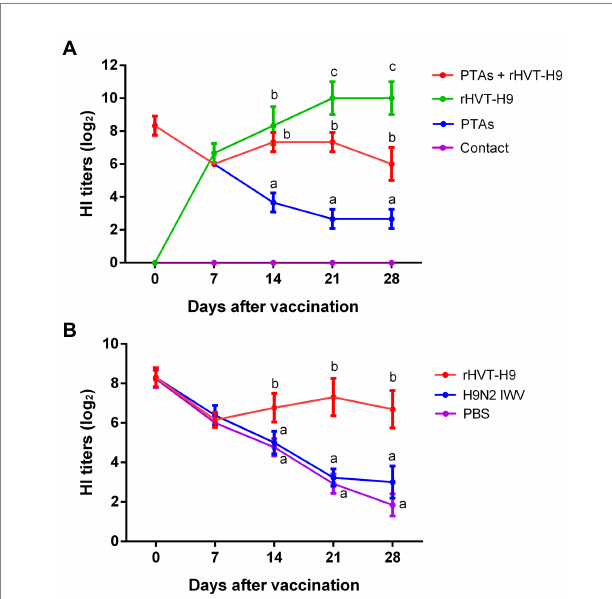
FIGURE 2 Humoral immune response induced in the preliminary and transmission animal experiment in chickens. (A) Sera were collected from the rHVT-H9 immunized chickens with or without PTAs ( n = 3/ group) weekly after vaccination and detected by HI assay. PBS inoculated chickens with PTAs were served as negative control. SPF chickens were contacted with the rHVT-H9 inoculated chickens without PTAs. (B) Sera were collected from the rHVT-H9 or H9N2 IWV vaccine inoculated chickens with PTAs ( n = 13/group) weekly after vaccination and detected by HI assay. PBS inoculated chickens with PTAs were used as negative control. Significant differences were calculated using Tukey test, posed ANOVA. p ≤ 0.05 was considered to be significant. The different letters indicate significant differences between the groups at the same time point.